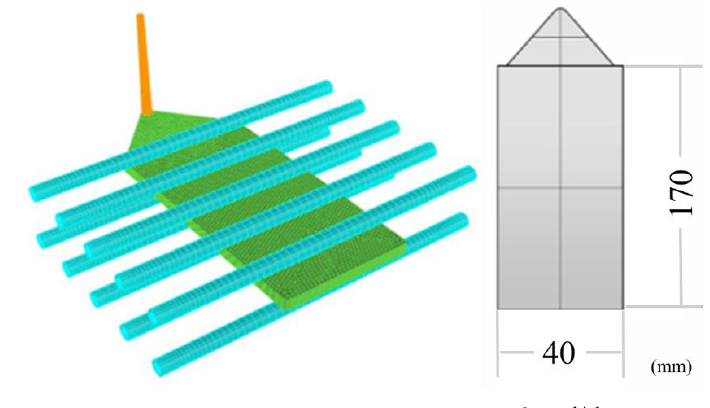
Figure 1. Plate-part mold used for molding experiments.